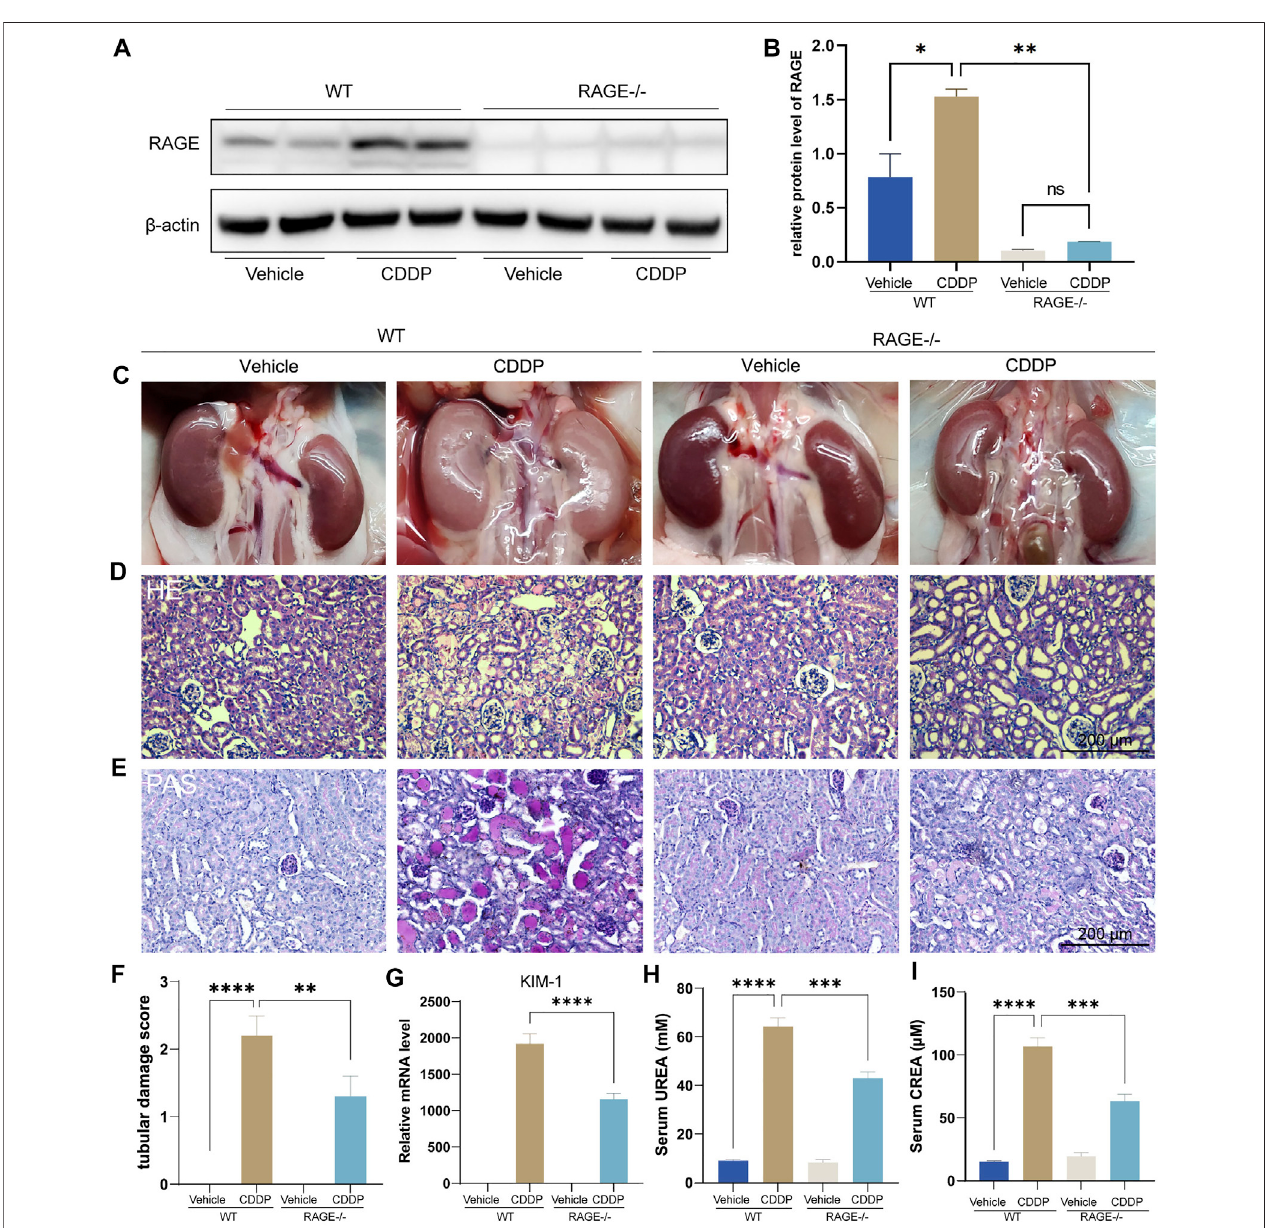
FIGURE 1 | RAGE knockout attenuated cisplatin-induced nephropathy. The protein level of RAGE was detected by western blot (A) and semi-quanti fi ed in a histogram (B) . (C) Representative macroscopic murine kidneys. (D) HE staining of paraf fi n sections of mouse kidneys. (E) PAS staining and (F) corresponding tubular injuryscoresofparaf fi nsectionsofmousekidney. (G) DetectionofmRNAlevelofKIM-1,amarkerofkidneyinjurybyqPCR. (H,I) DeterminationofUREAandCREAlevels in mice. One-way ANOVA was used to compare means between groups. Data are expressed as mean ± SEM. Scare bar: 200 μ m. ** p < 0.01, *** p < 001, **** p < 0.0001. WT, wild type; CDDP,